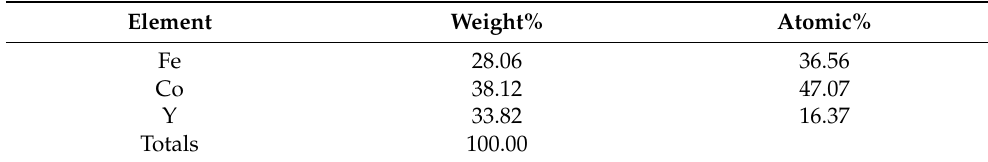
Table 3. EDX analysis data for alloy fi lms.